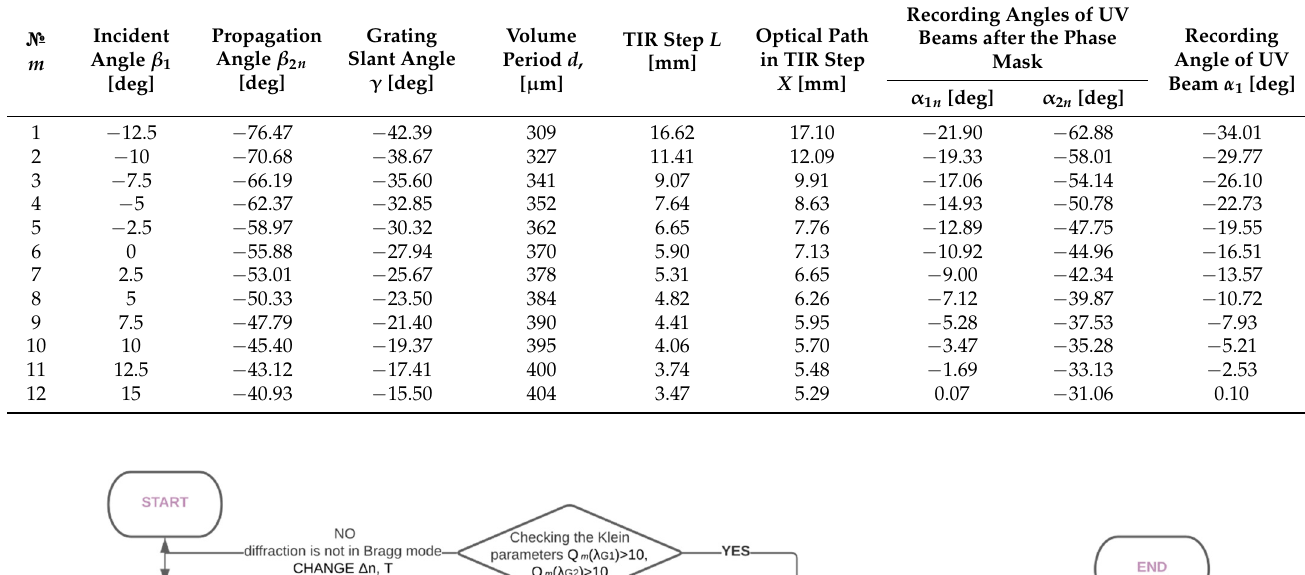
Table A1. Calculation results for MVHGs used in green spectral channel in diffraction waveguide.